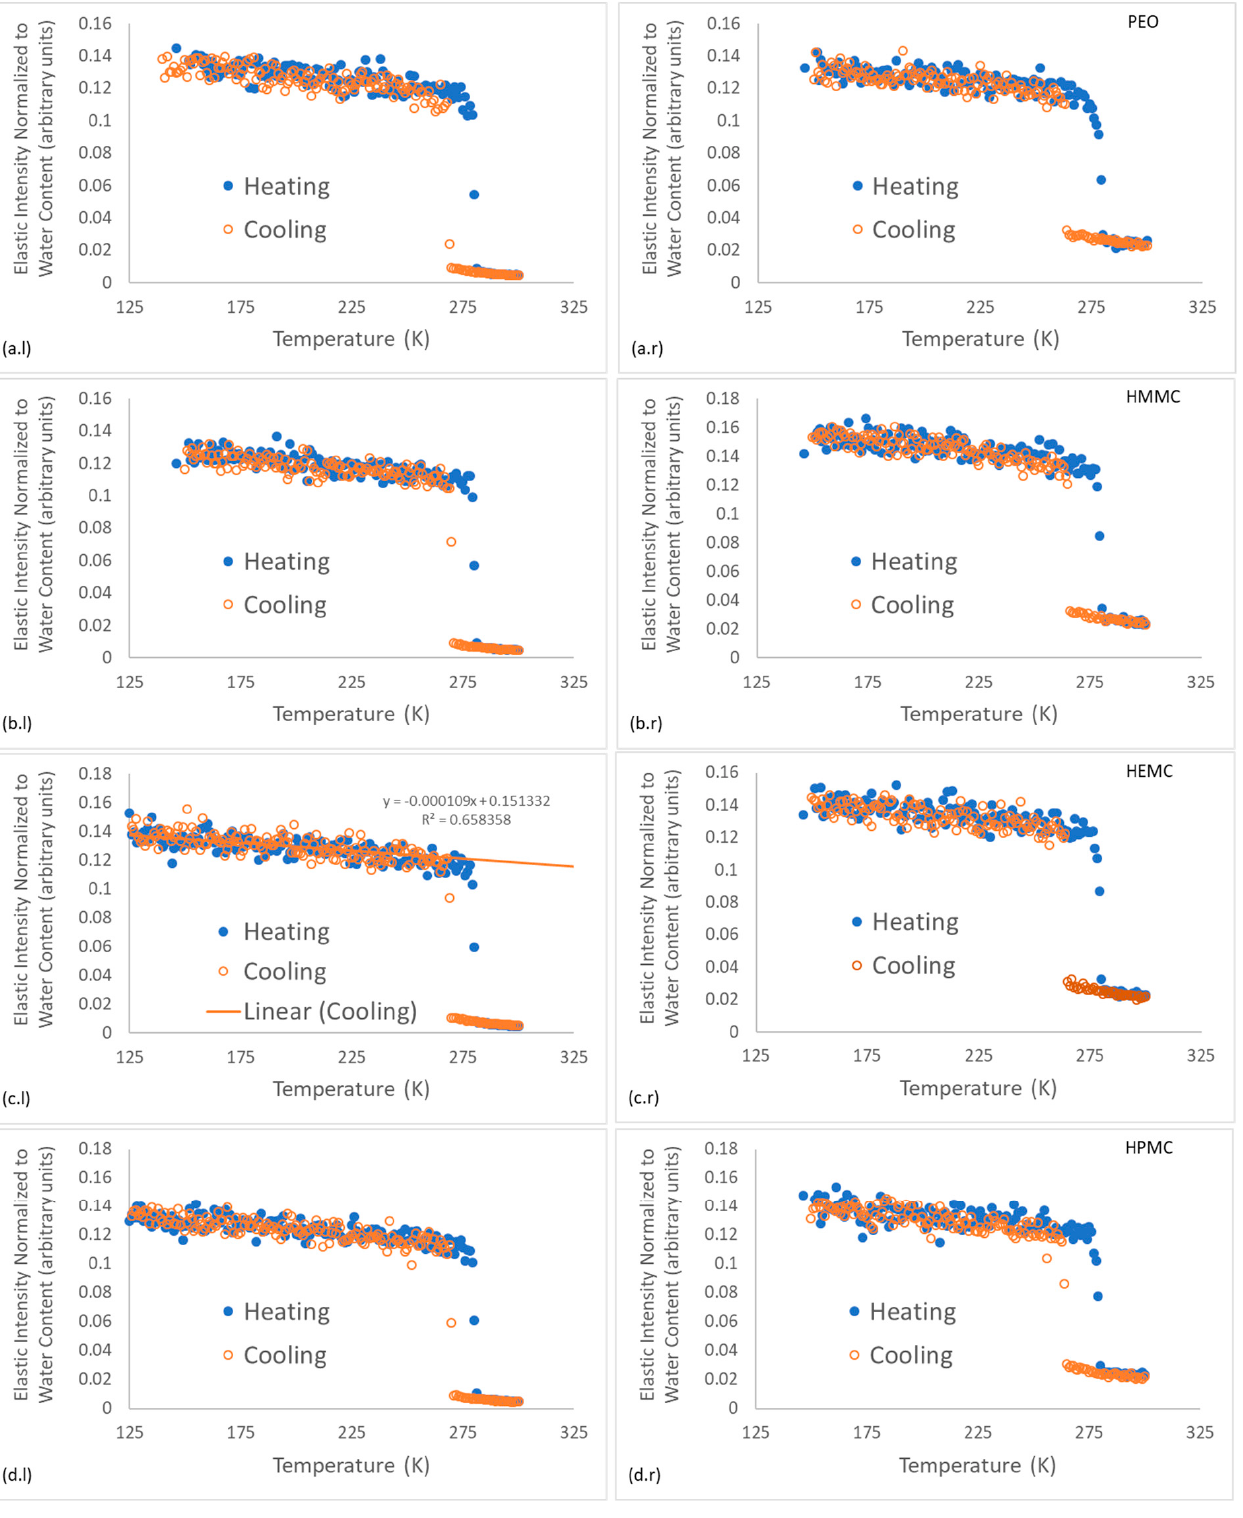
Figure 7. Energy-resolved “elastic” scattering data for hydrogels and hydrogel-cement pastes; the cooling curves are plotted with solid markers and the heating curves are plotted with open markers. Figures on the left ( l ) are the neat gels and figures on the right ( r ) are the gel-cement pastes. Subfigures are shown for each gel type: ( a ) PEO, ( b ) HMMC, ( c ) HEMC and ( d )